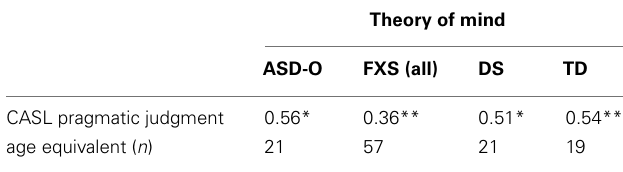
Table 3 | Correlations between theory of mind and pragmatic language on the CASL.